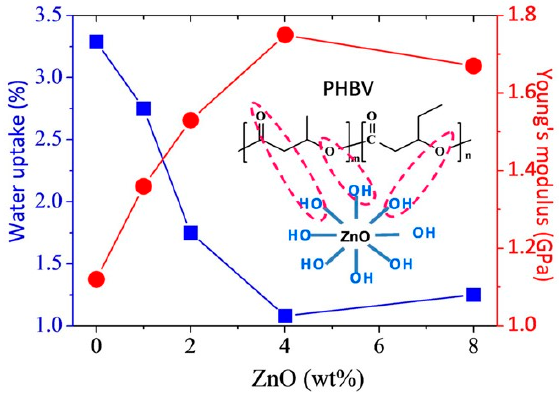
Figure 11. Young’s modulus and water uptake of PHBHV/ZnO film. Reprinted with permission from [132]. Copyright 2014 American Chemical Society.